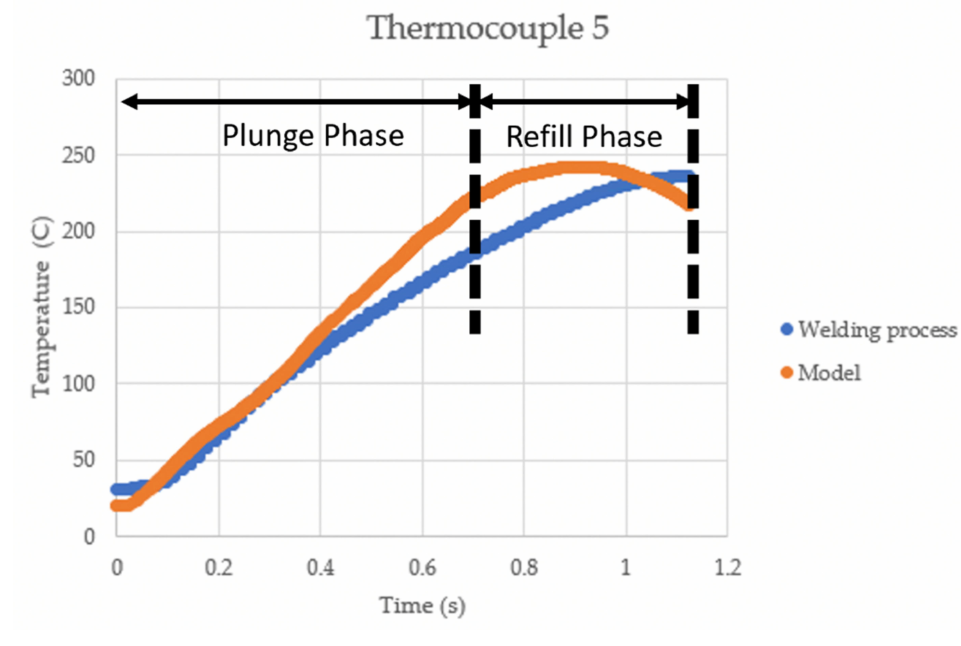
Figure 12. Thermal comparison for Thermocouple 5.